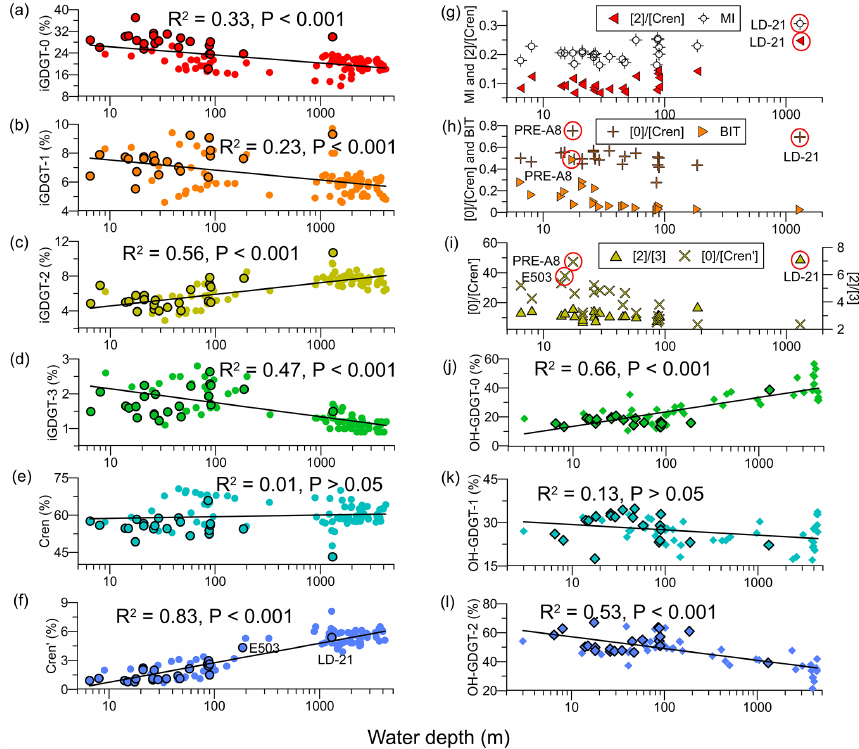
Figure 5. Depth profiles of (a) iGDGT-0, (b) iGDGT-1, (c) iGDGT-2, (d) iGDGT-3, (e) Cren, (f) Cren (cid:48) , (g) [2] / [Cren] ratio and MI values, (h) [0] / [Cren] ratio and BIT values, (i) [2] / [3] and [0] / [Cren (cid:48) ] ratios, (j) OH-GDGT-0, (k) OH-GDGT-1, and (l) OH-GDGT-2. Shapes with black outlines are data from this study, and shapes without black outlines are data from Ge et al. (2013), Lü et al. (2015), Jia et al. (2017), Wei et al. (2011), Yang et al. (2018), and Zhou et al. (2014). Black curves are lognormal